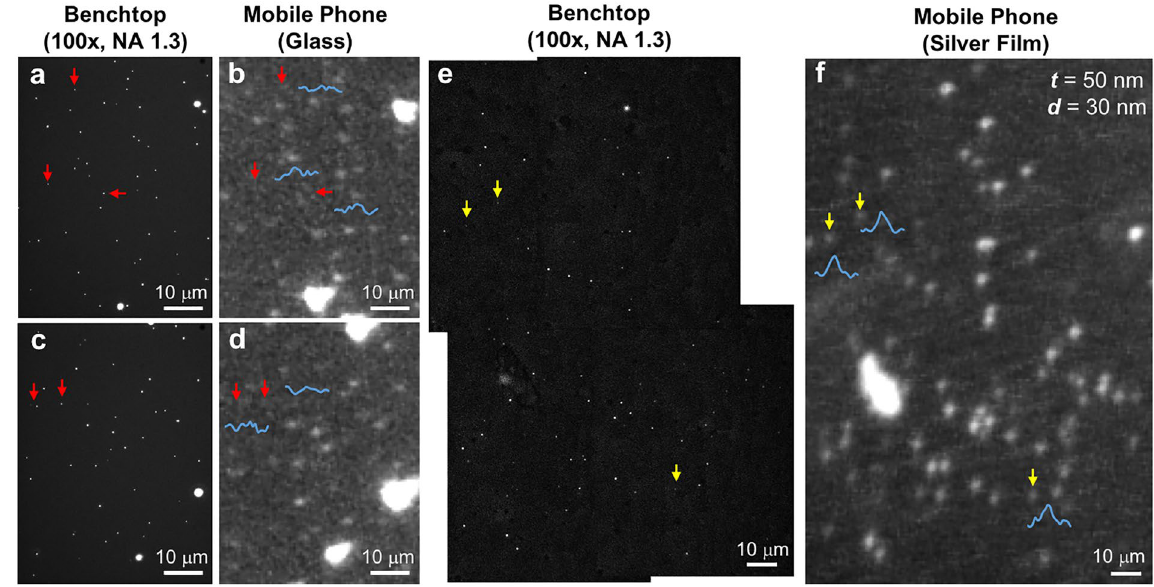
Figure 4. Imaging of individual 50 nm fluorescent beads using the smartphone SEF microscope. ( a – d ) Control experiments by imaging the 50 nm fluorescent bead samples with a benchtop microscope ( a , c ) and a previous mobile phone microscopy device using glass substrates ( b , d ), respectively. Some examples of missed 50 nm particles by the glass-based mobile phone imaging device are highlighted by red arrows, and the corresponding intensity line scans shown in blue curves. ( e , f ) Detection of individual 50 nm particles by the newly developed mobile phone SEF imaging device ( f ); the same field-of-view was also imaged by a conventional benchtop microscope ( e ), 4 images stitched together. Yellow arrows indicate some examples of the detected 50 nm particles and blue curves show their corresponding intensity line